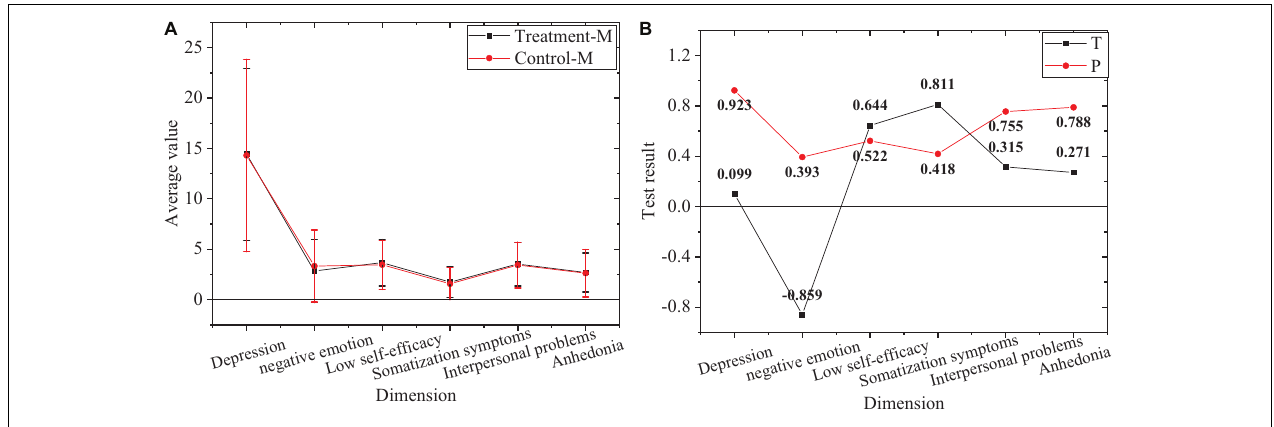
FIGURE 4 | Comparison of negative emotions. (A) Average of treatment group and control group. (B) Value of T and P of treatment group and control group.